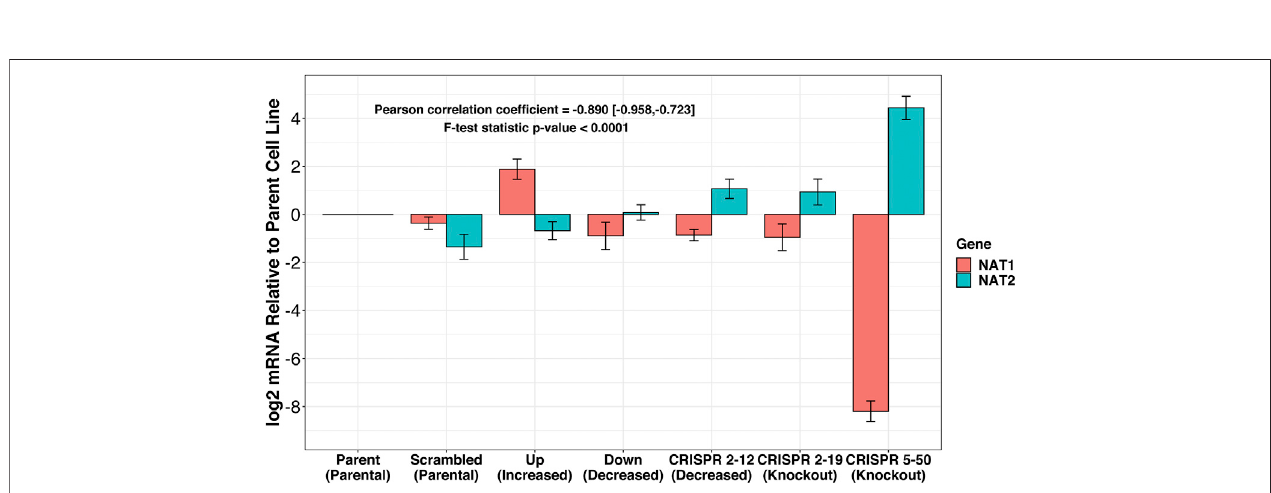
FIGURE7| RT-qPCRcon fi rmsinverserelationshipbetweenNAT1andNAT2expressioninourcelllines.PCRprobesdesignedtodiscriminatebetweenNAT1and NAT2 were utilized for real-time quantitative polymerase chain reactions. mRNA expression was normalized to the expression of the parental MDA-MB-231 cell line. A trend of decreased NAT1 expression and increased NAT2 expression was observed. * p ≤ 0.05, *** p ≤ 0.001.